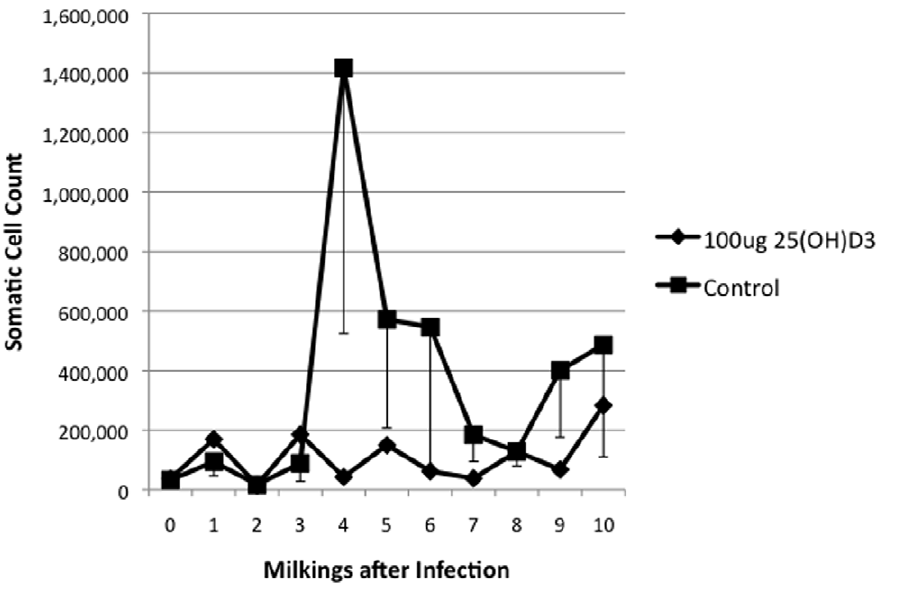
Figure 3. Somatic Cell Counts in Control and 25(OH)D 3 Treated Animals. Milk samples for somatic cells counts (SCC) were taken at each milking and sent to a DHIA facility for counting. The average SCC were determined for 25(OH)D 3 treated ( u ) and control animals( n ).